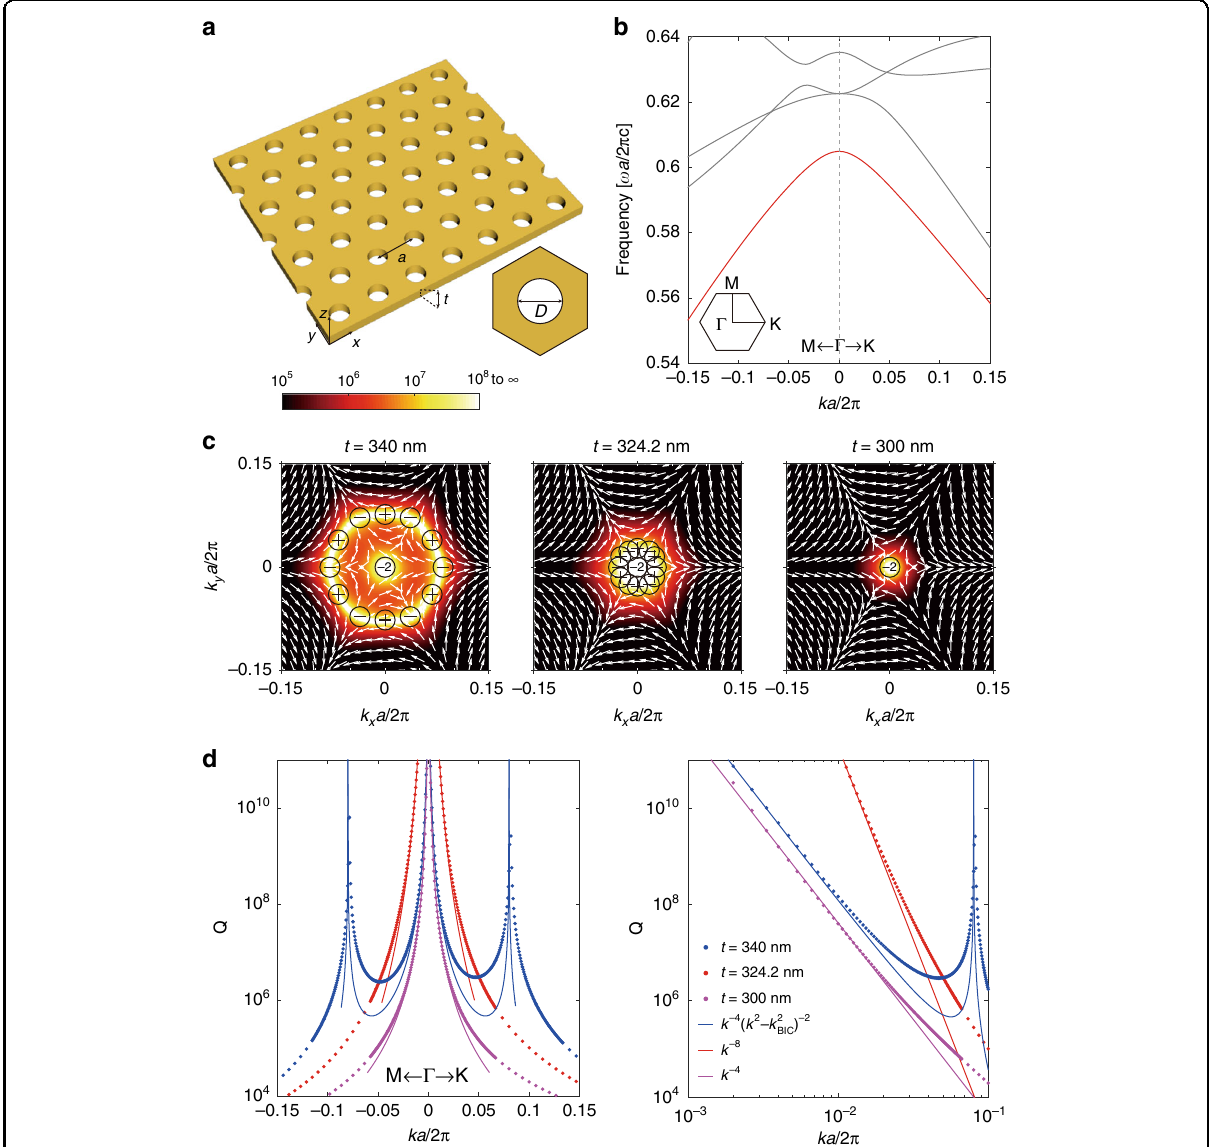
0 0.1 0.15–0.15 –0.1 ka /2 π Fig. 1 Merging multiple accidental BICs with a higher-order topological charge at Γ . a Schematics of a PCS with a triangular lattice of cylindrical holes etched onto a Si 3 N 4 slab and immersed in a liquid. The lattice constant is a = 336 nm and the diameter of the hole is D = 160 nm. The inset is the top-view of the unit cell. b Simulated TE-like band structure at t = 340 nm. The lowest TE-like band is highlighted in red. The inset shows the fi rst Brillouin zone. c Simulated polarization vectors around the BICs with the Q factors as the background color for the lowest TE-like band at different thicknesses. When t is tuned from 340 nm to 300 nm, a chain of BICs with topological charge ± 1 merges into a symmetry-protected BIC with charge − 2. d Simulated Q factors (dotted lines) and the corresponding fi tting curves (solid lines). The right panel shows the scaling rules along the Γ K direction, and the scaling rules are the same along the Γ M direction. Merging BIC ( t = 324.2 nm) has considerably enhanced the Q factors of nearby states compared with isolated